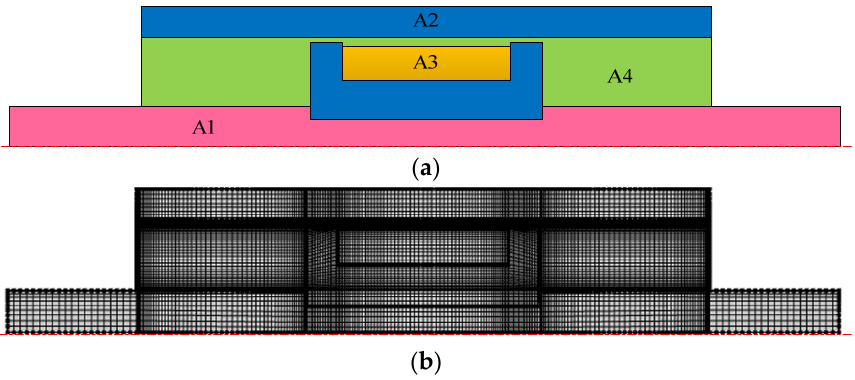
Figure 4. Simulation model of the MR damper. ( a ) Entity model, ( b ) finite element model. Table 1. Key structural parameters of MR damper.